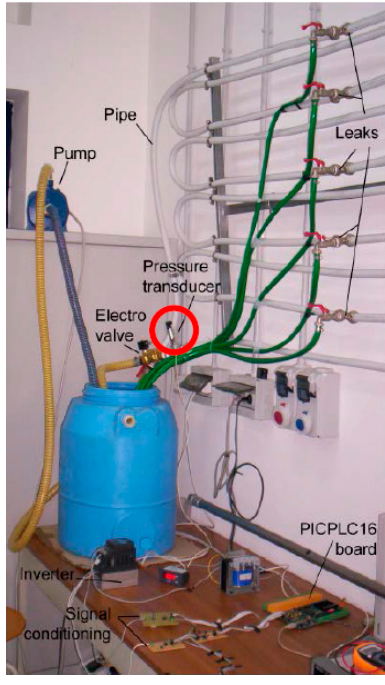
Figure 3. Experimental plant with three pressure sensors: ( top ) architecture and ( bottom ) real plant with circled pressure sensor.